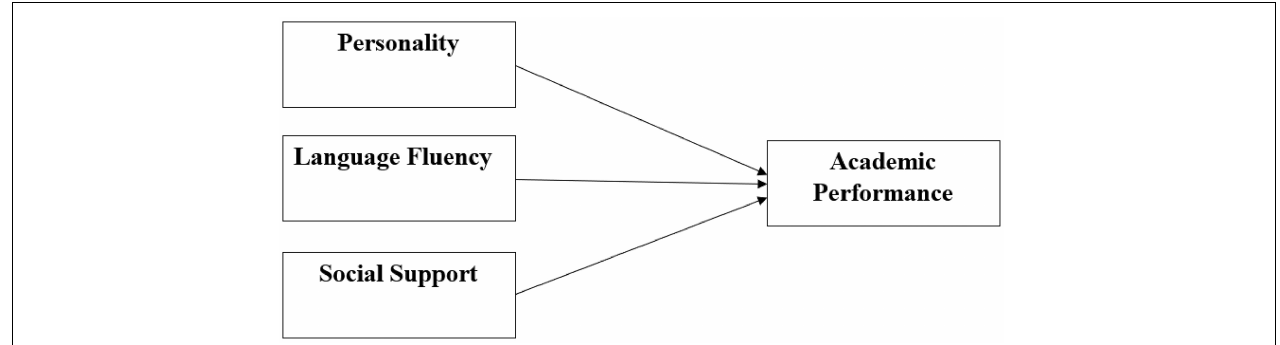
FIGURE 1 | Research